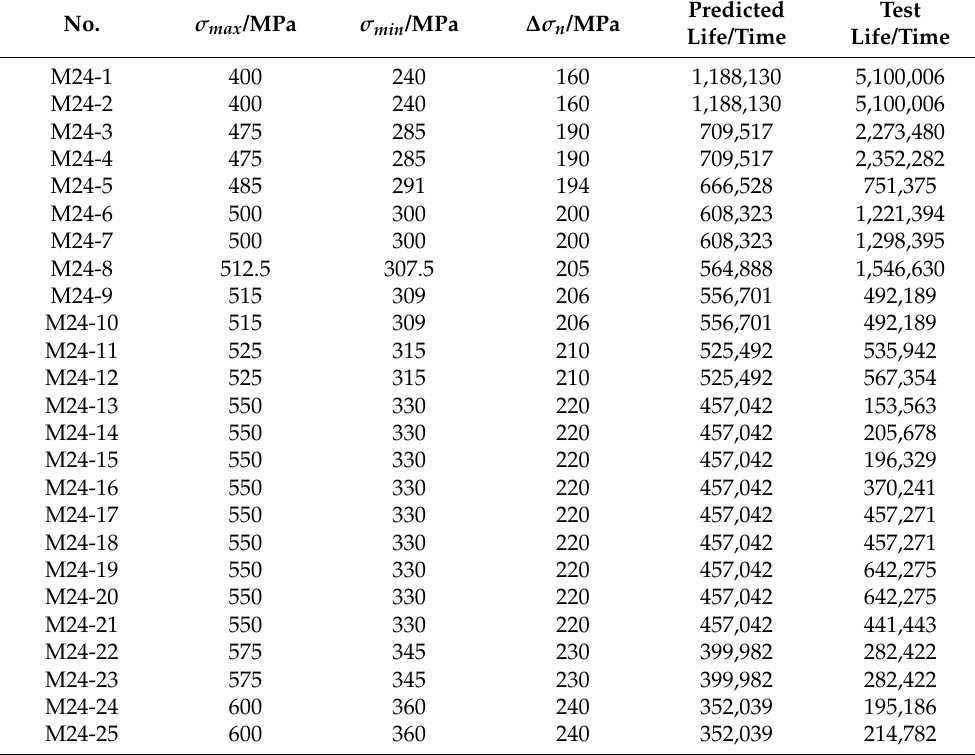
Table 12. Estimated fatigue life of M24 high-strength bolt a 0 = 0.05